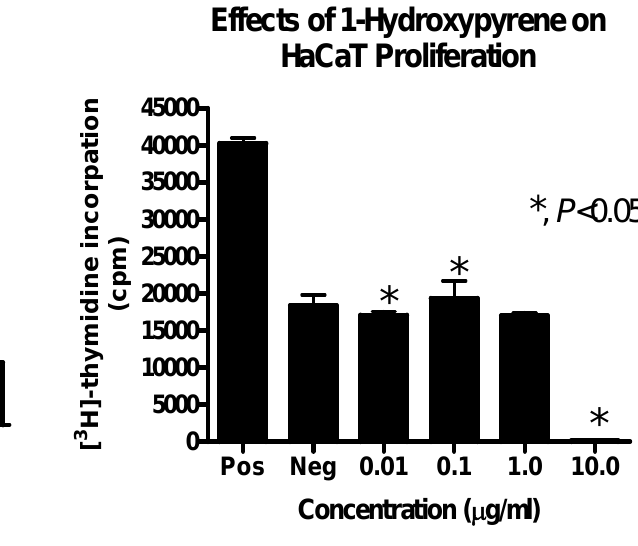
Figure 3: Effects of 1-hydroxypyrene on HaCaT proliferation. HaCaT cells were grown in 35mm plates to subconfluent in CGM. Cells were serum starved for 24 hours and then treated with pyrene at 0.01, 0.1, 1.0 and 10.0 μ g/ml concentrations for 18 hours. Thymidine incorporation assay was then performed as described in materials and methods. Results represent the mean +/- SD values of experiment performed in triplicate. [* indicates that treatment mean is significantly different from negative control according to Dunett test ( p <0.05)].